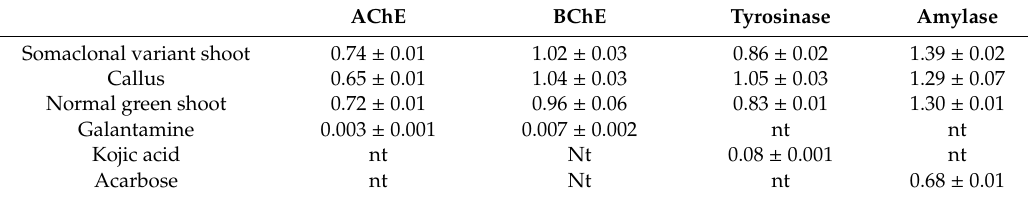
Table 13. Enzyme inhibitory e ff ects of the tested extracts (IC50 (mg / mL)).